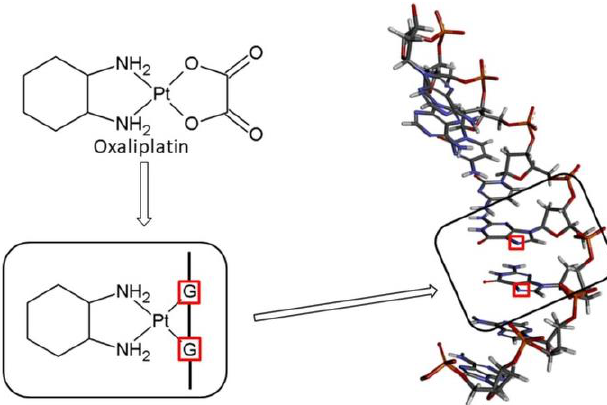
Figure 2. Pathway of Oxaliplatin and anticancer activity.